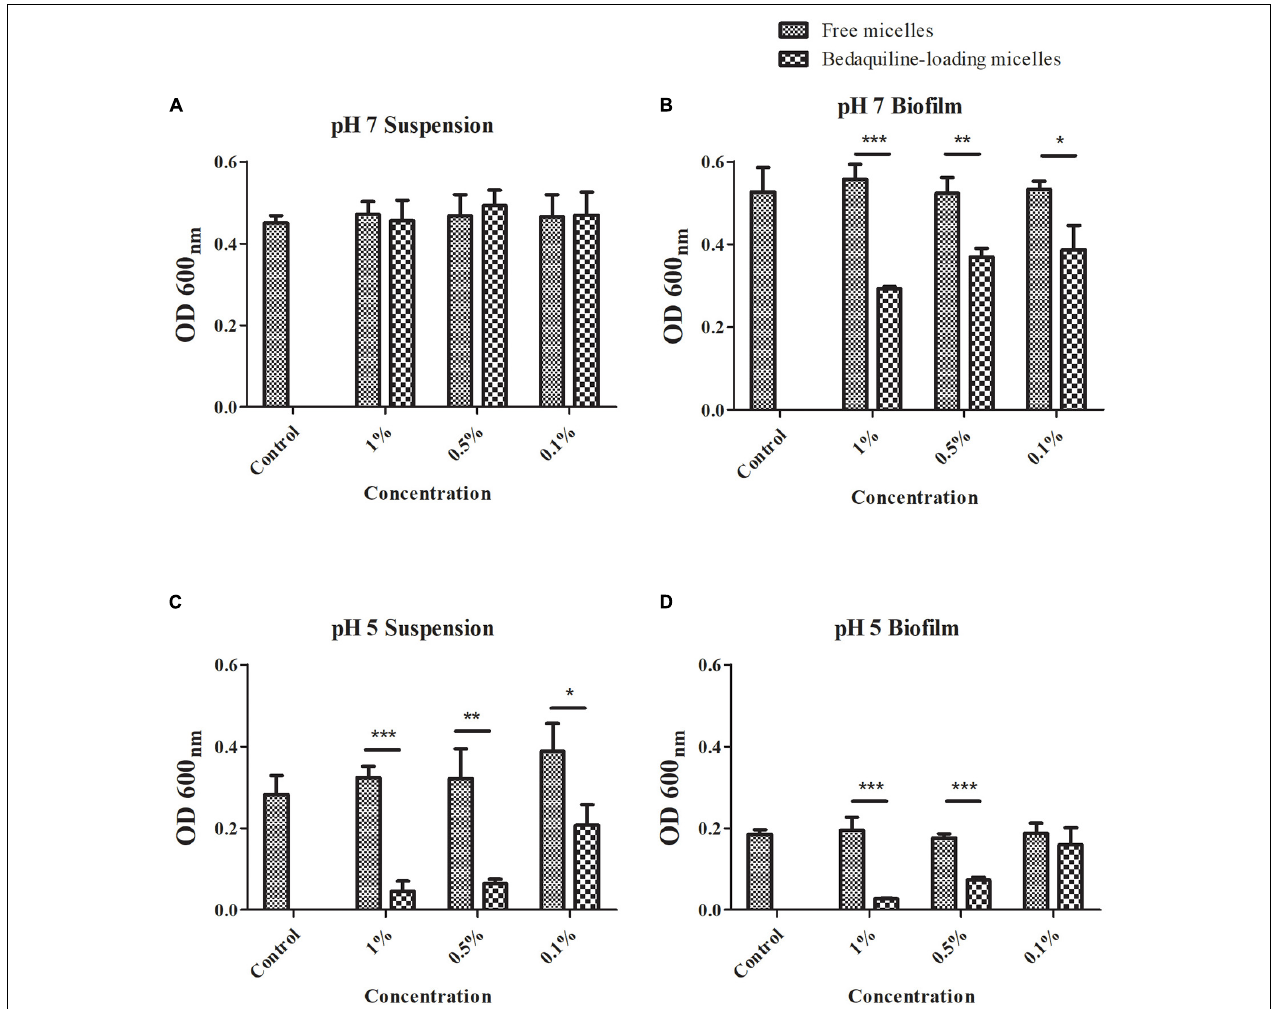
FIGURE 3 | Antibacterial effect of free micelles and bedaquiline-loading micelles at pH 7 and 5 BHI broth. At pH 7, antibacterial effect of free micelles and bedaquiline-loading micelles at 0.1, 0.5, and 1% ratio (v/v%) against (A) Streptococcus mutans suspension and (B) biofilm formation. At pH 5, antibacterial effect of free micelles and bedaquiline-loading micelles against (C) S. mutans suspension and (D) biofilm formation. * P < 0.05, ** P < 0.005, and *** P <